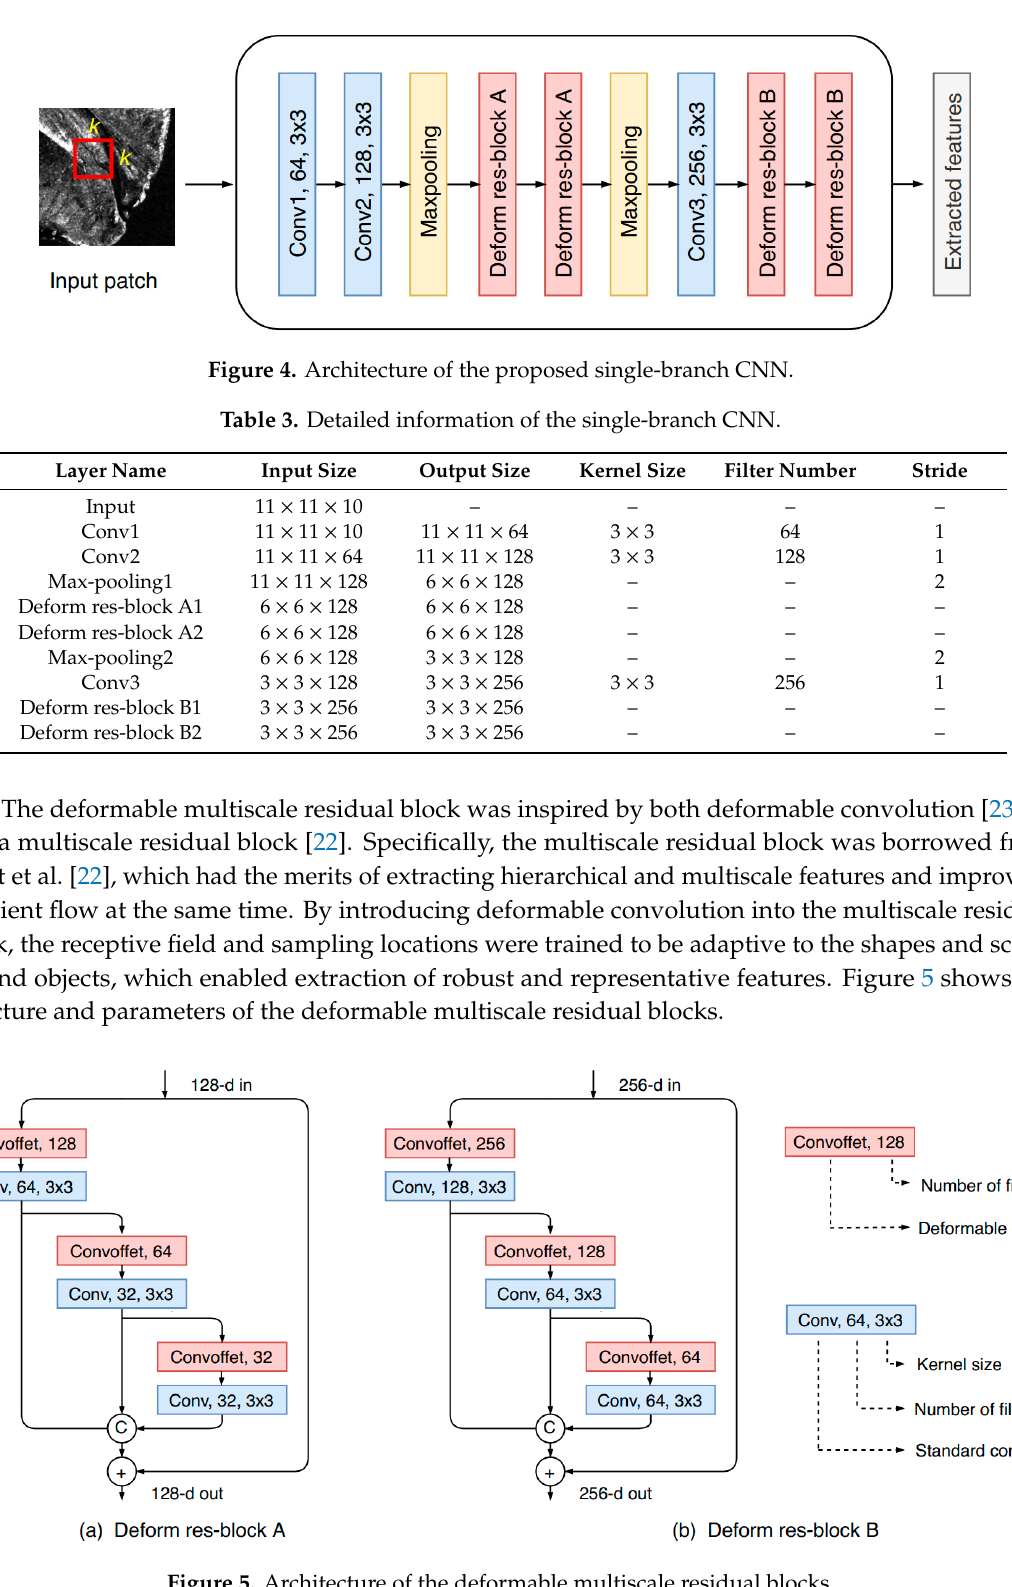
Figure 5. Architecture of the deformable multiscale residual blocks.